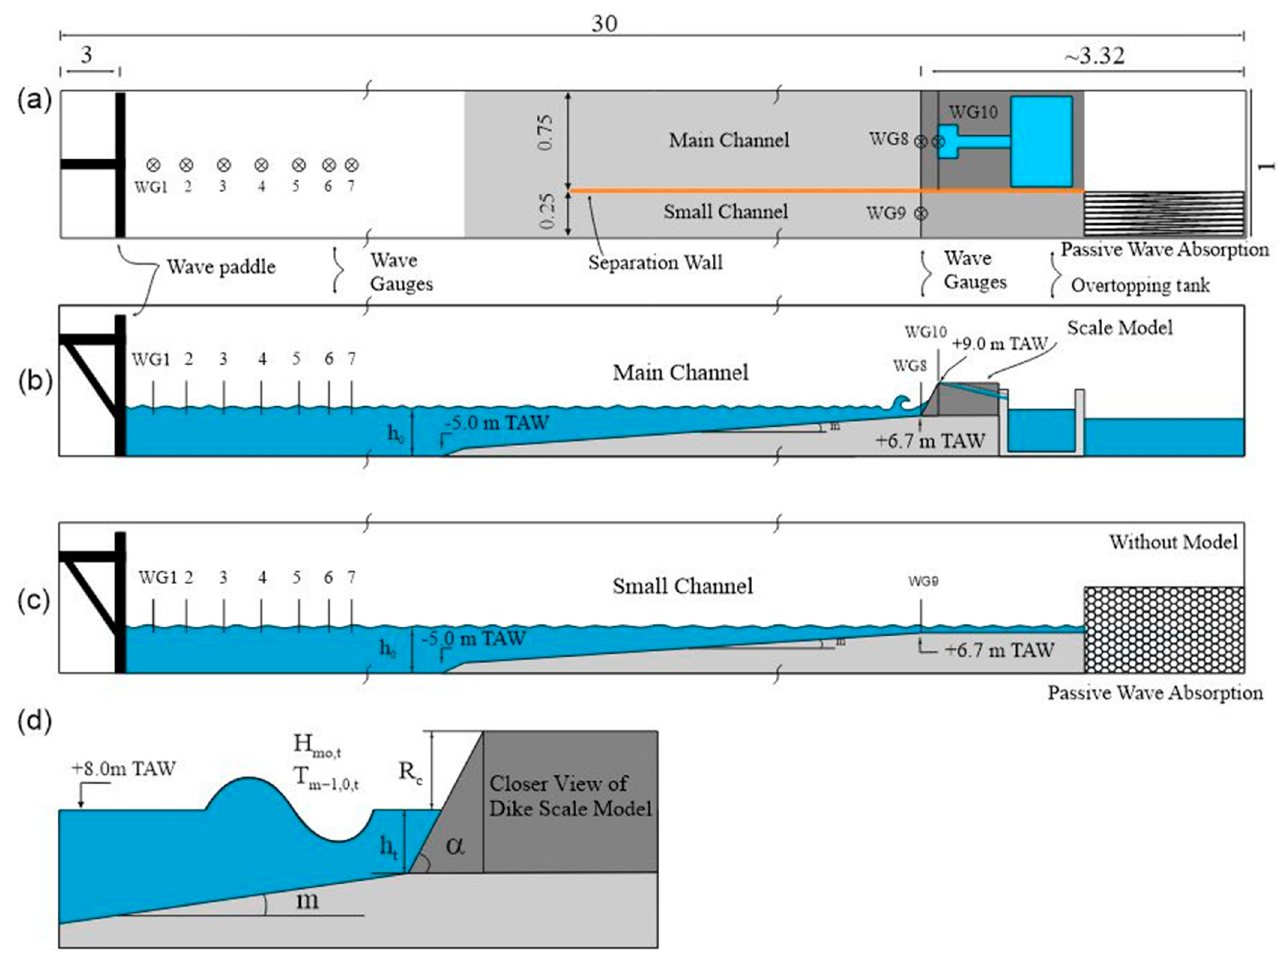
Figure 1. Small-scale model set up for the overtopping tests. ( a ) is the top view, ( b ) is the side view of the main channel, ( c ) is the side view of the small channel, and ( d ) is the detailed view of the scale model.